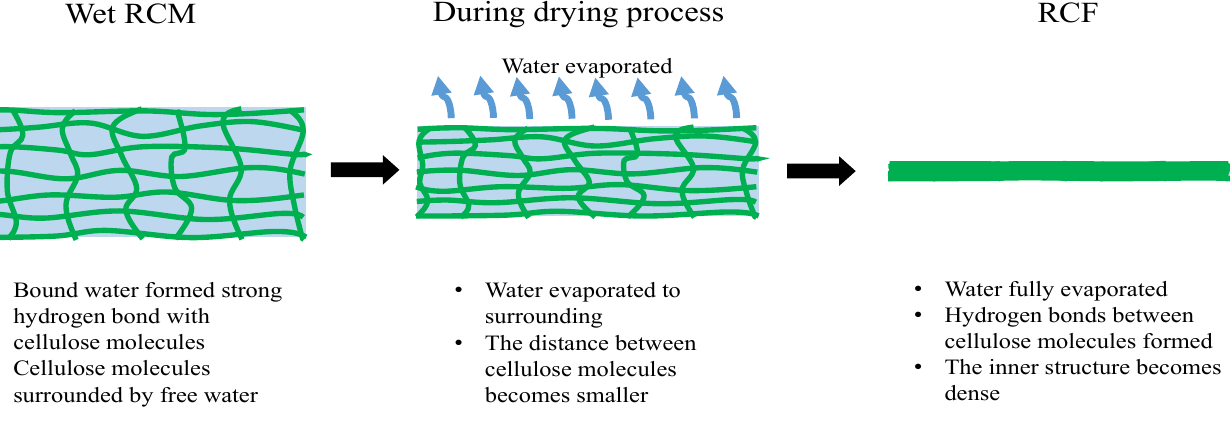
Figure 5. Schematic of the drying process and its effect on RCF molecular structure arrangement.